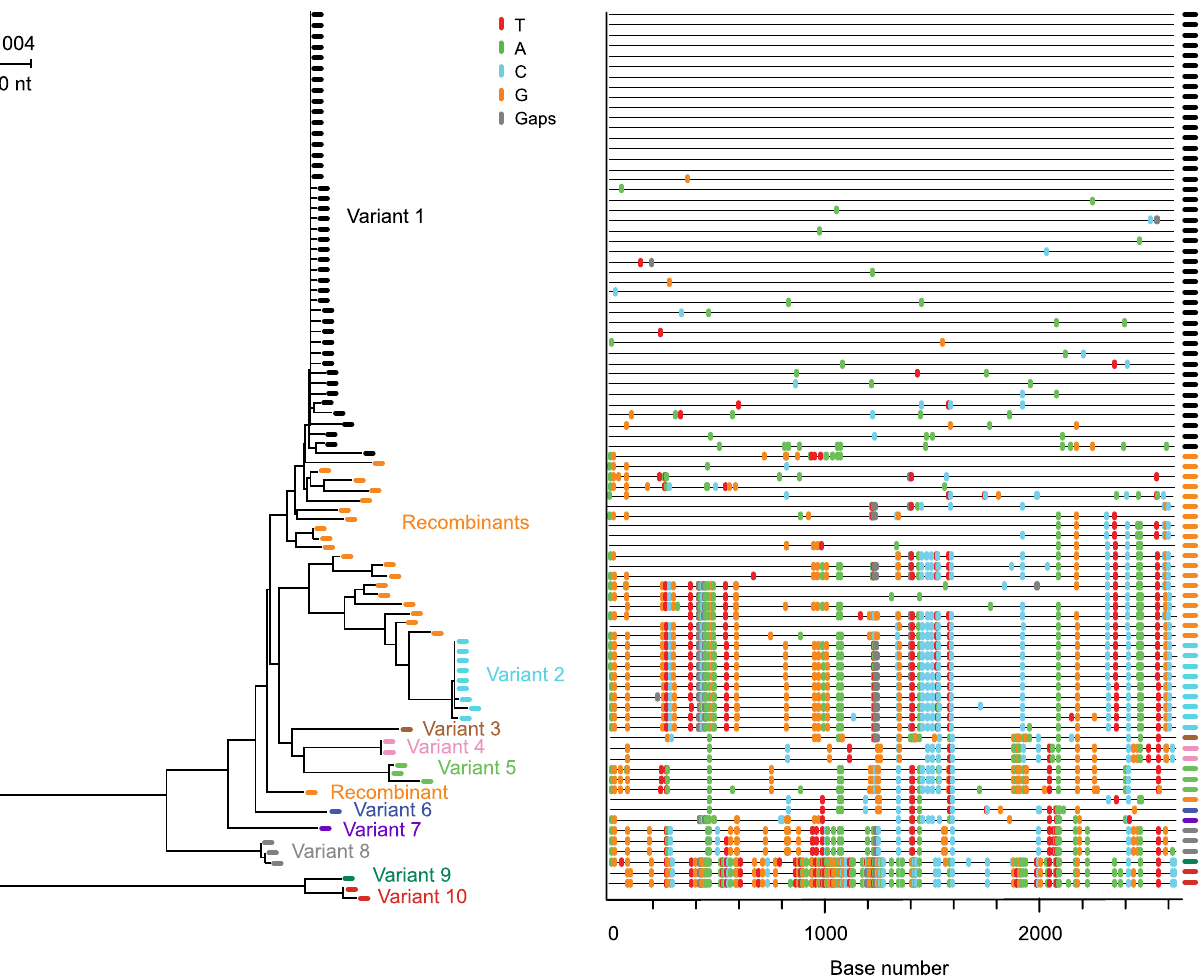
Figure 6. NJ tree and Highlighter plot of HIV-1 env diversity in subject 04013171. Sequences emanating from ten transmitted/founder viruses are color-coded and identified as variants 1–10. Inter-lineage recombinants are depicted in orange. The horizontal scale bar represents genetic distance.